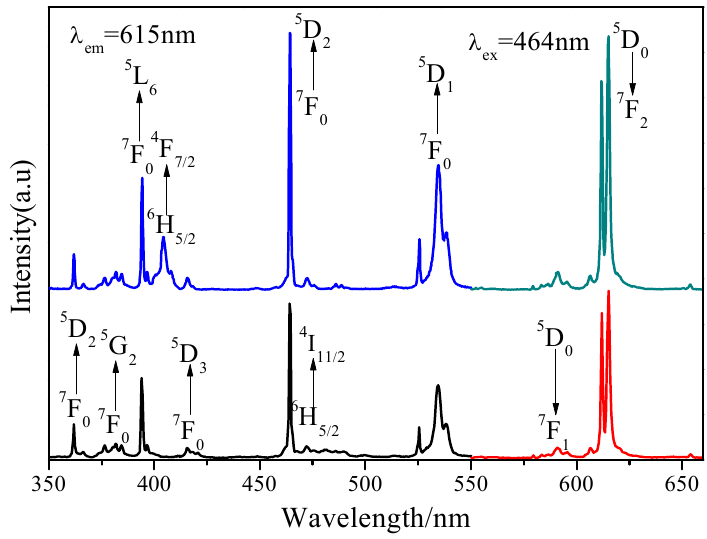
Figure 5. PLE and PL spectra of NL 85% MO:15%Eu 3+ and NL 83% MO:15%Eu 3+ ,2%Sm 3+ .